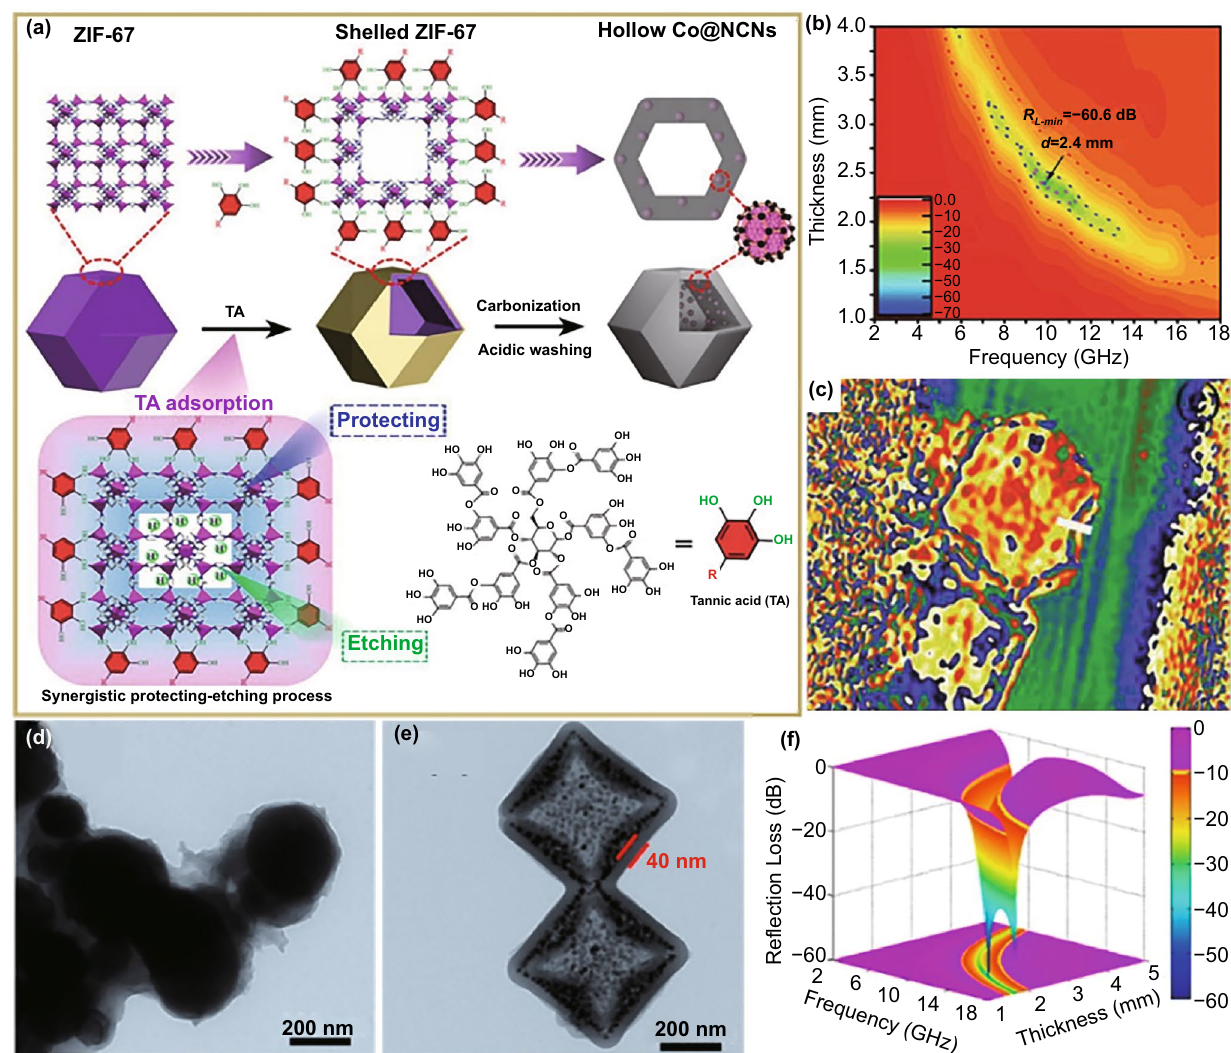
Fig. 7 a Schematic illustration for the synthetic procedure of hollow Co@NCNs. b RL maps and c charge density map of hollow Co@NCNs- 800 . Reproduced with permission from Ref. [129] . Copyright © 2021 Wiley–VCH GmbH . TEM images of d NiCo@C-0 and e NiCo@C-2; f 3D RL map of NiCo@C-2 . Reproduced with permission from Ref. [134] . Copyright © 2020 Elsevier